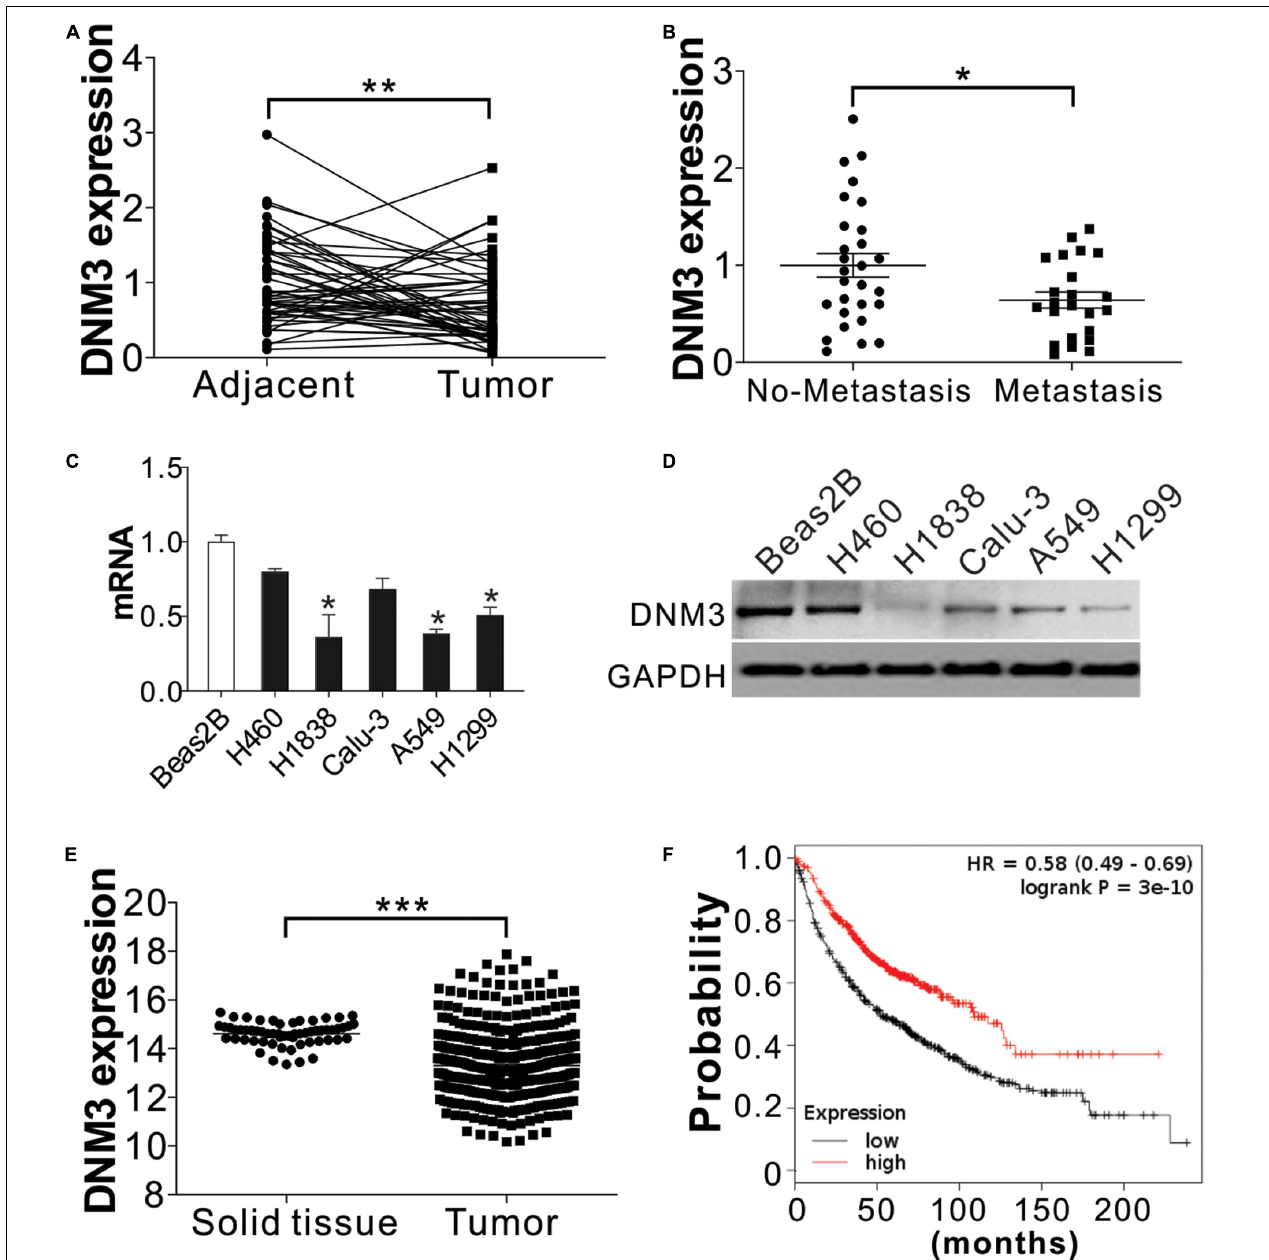
FIGURE 1 | DNM3 expression is low in LC cells in vivo and in vitro . (A) mRNA level of DNM3 in 51 pairs of adjacent tissues and primary tumors from patients with lung cancer (LC). β -ACTIN was used as reference gene. (B) mRNA level of DNM3 in the tumor samples from patients with ( n = 23) or without ( n = 28) cancer metastasis. β -ACTIN was used as the reference gene. (C) mRNA level of DNM3 in the indicated cells. GAPDH was used as the reference gene. (D) The protein level of DNM3 in the indicated cells. (E) Expression of DNM3 in LC tumors and solid normal tissues according to database of cancer browser (https://xena.ucsc.edu/welcome-to-ucsc-xena/). (F) Survival of patients with high- or low-DNM3-expressing LC based on data analysis with the Kaplan–Meier plotter (http://kmplot.com/analysis/index.php?p=service&cancer=lung). Experiments in (C,D) were repeated 3 times. * p < 0.05; ** p < 0.01; *** p <